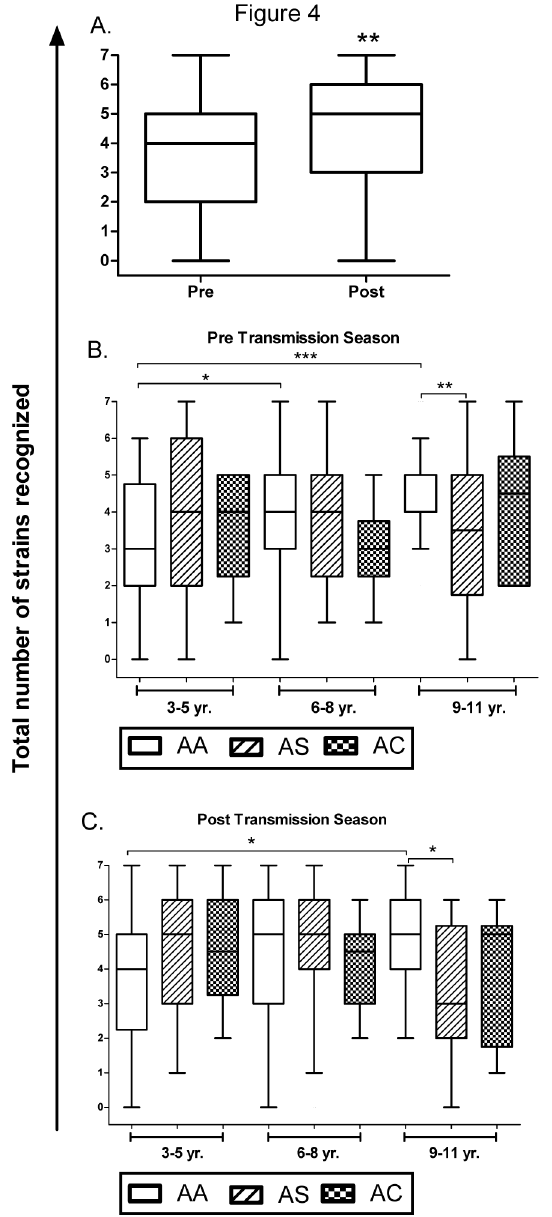
Figure 4. Breadth of IgG responses to parasite strains stratified by season, Hb type and age. The number of parasite strains (range, 0-7) recognized by IgG were counted and stratified by season, Hb type and age. a , Tukey whisker plots showing the total number of parasite strains recognized by IgG in paired plasma samples taken before and after the 2009 transmission season. p-values were calculated using Wilcoxon matched-pairs signed rank test. **p<0.01. b , c , Tukey whisker plots showing the total number of parasite strains recognized by IgG before ( b ) and after ( c ) the 2009 transmission season, stratified by age and Hb type. p-values were calculated using Kruskal-Wallis test followed by Dunn’s multiple comparison test. *p<0.05, **p<0.01, ***p<0.001.